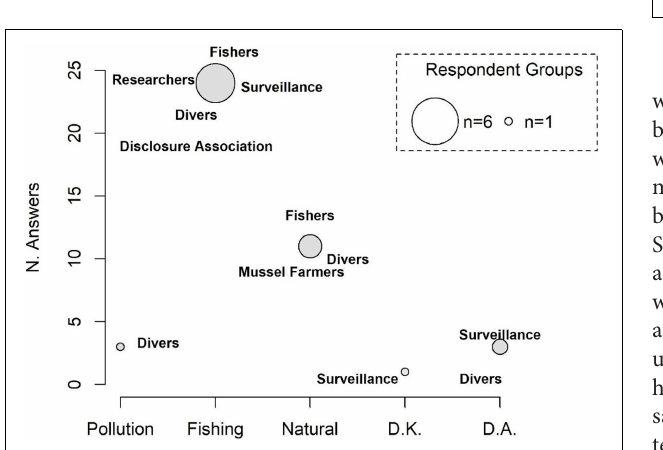
FIGURE 7 | Presence of a target fishery. The size of the circle is proportional to the number of responding categories. D.K., do not know; D.A., do not